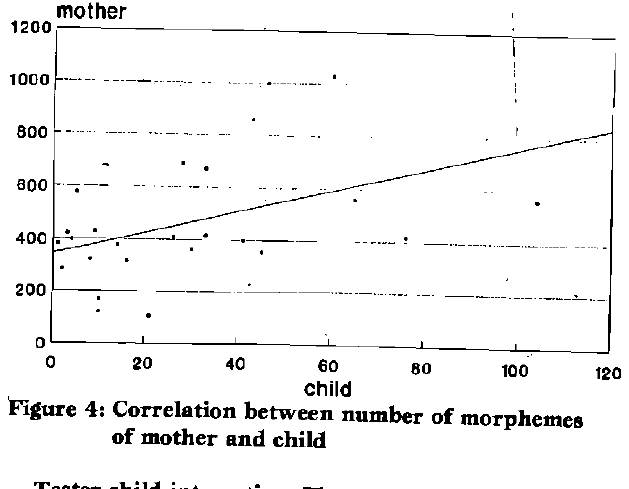
Figure 4: Correlation between number of morphemes of mother and